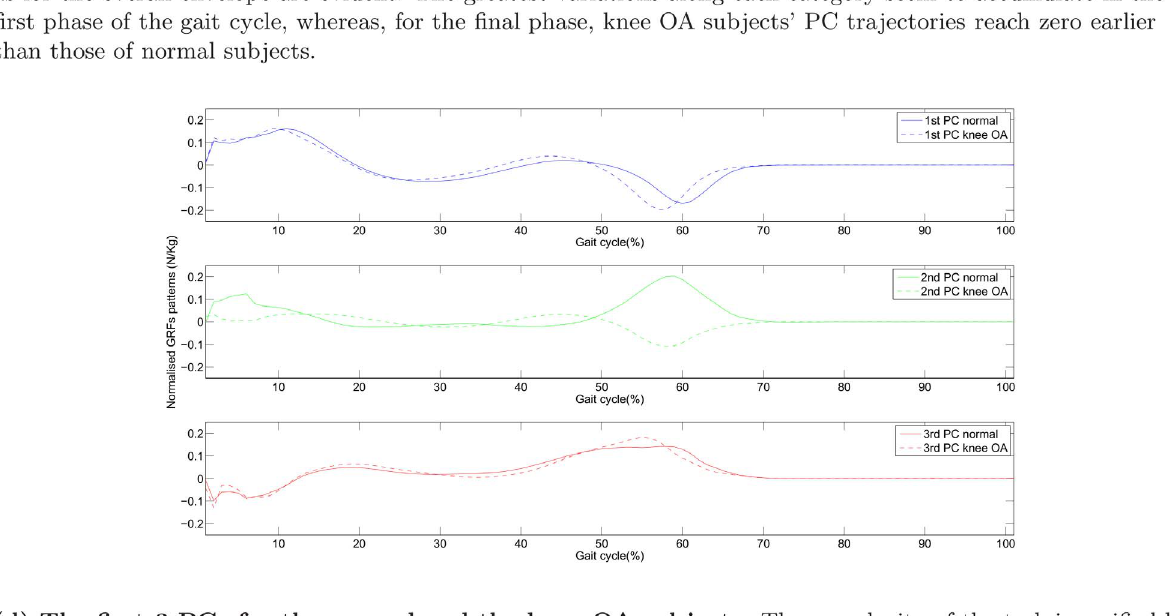
Figure 8. PC visualisations as discriminants of the two classes: normal subjects vs. knee OA subjects. doi:10.1371/journal.pone.0107325.g008 PLOS ONE |